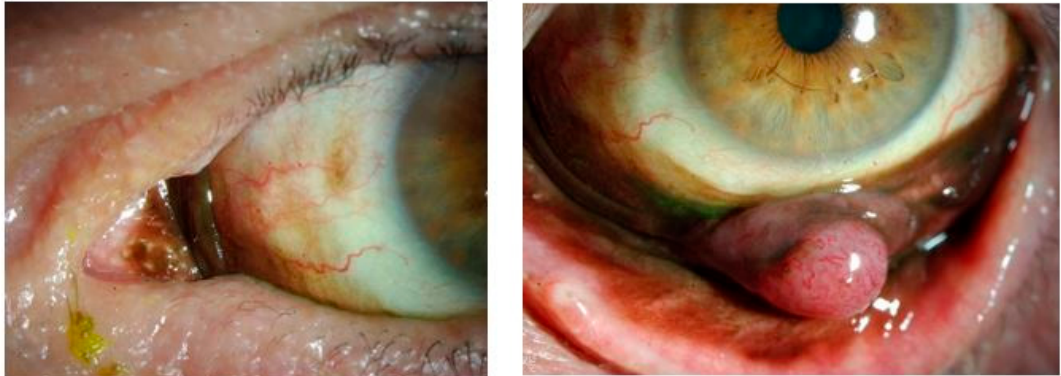
Figure 3. Primary acquired melanosis ( left ), conjunctival melanoma ( right ) in the same